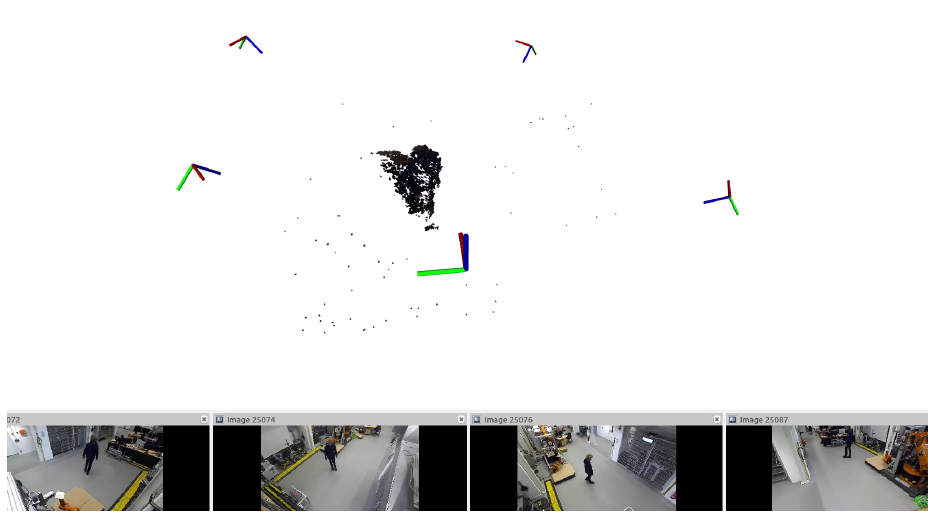
Figure 6. Foreground point cloud of a walking person after merging, generated by background subtraction on rg chromaticity color space.